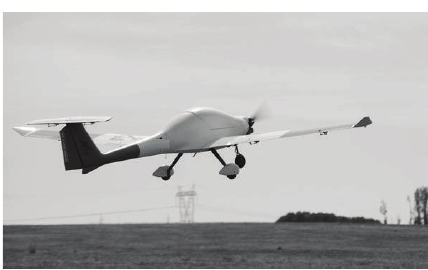
Figure 20: KUAV during test